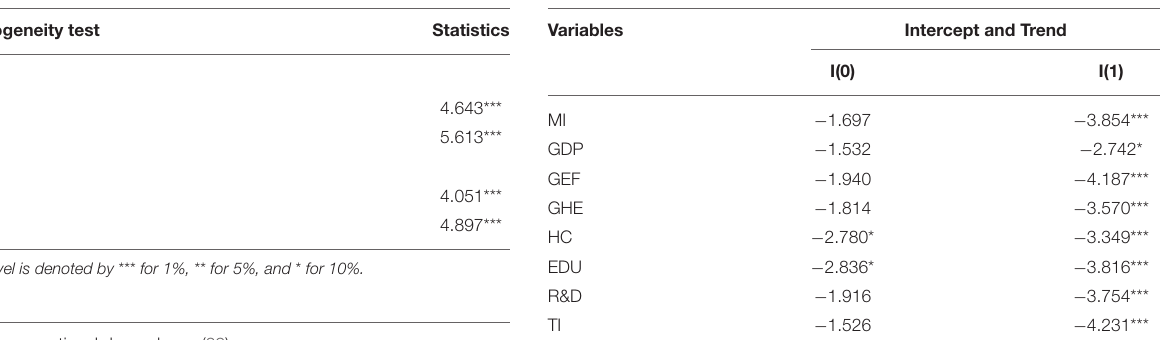
TABLE 5 | Cross-sectional dependence (39).